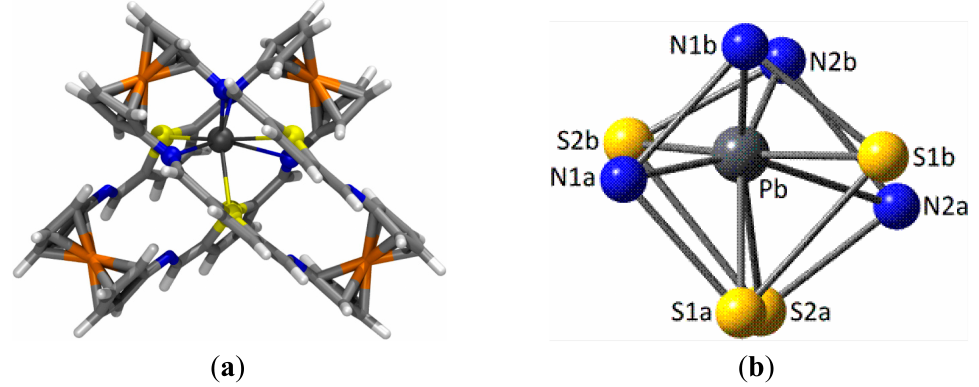
Figure 7 : ( a ) Computed (B3LYP-D3/def2-TZVPecp) most stable geometry for complex 4 ·Pb 2+ . Capped sticks representation except for the central metal cation and directly linked 2 donor atoms that are highlighted in ball representation; ( b ) Simplified coordination sphere around the central Pb 2+